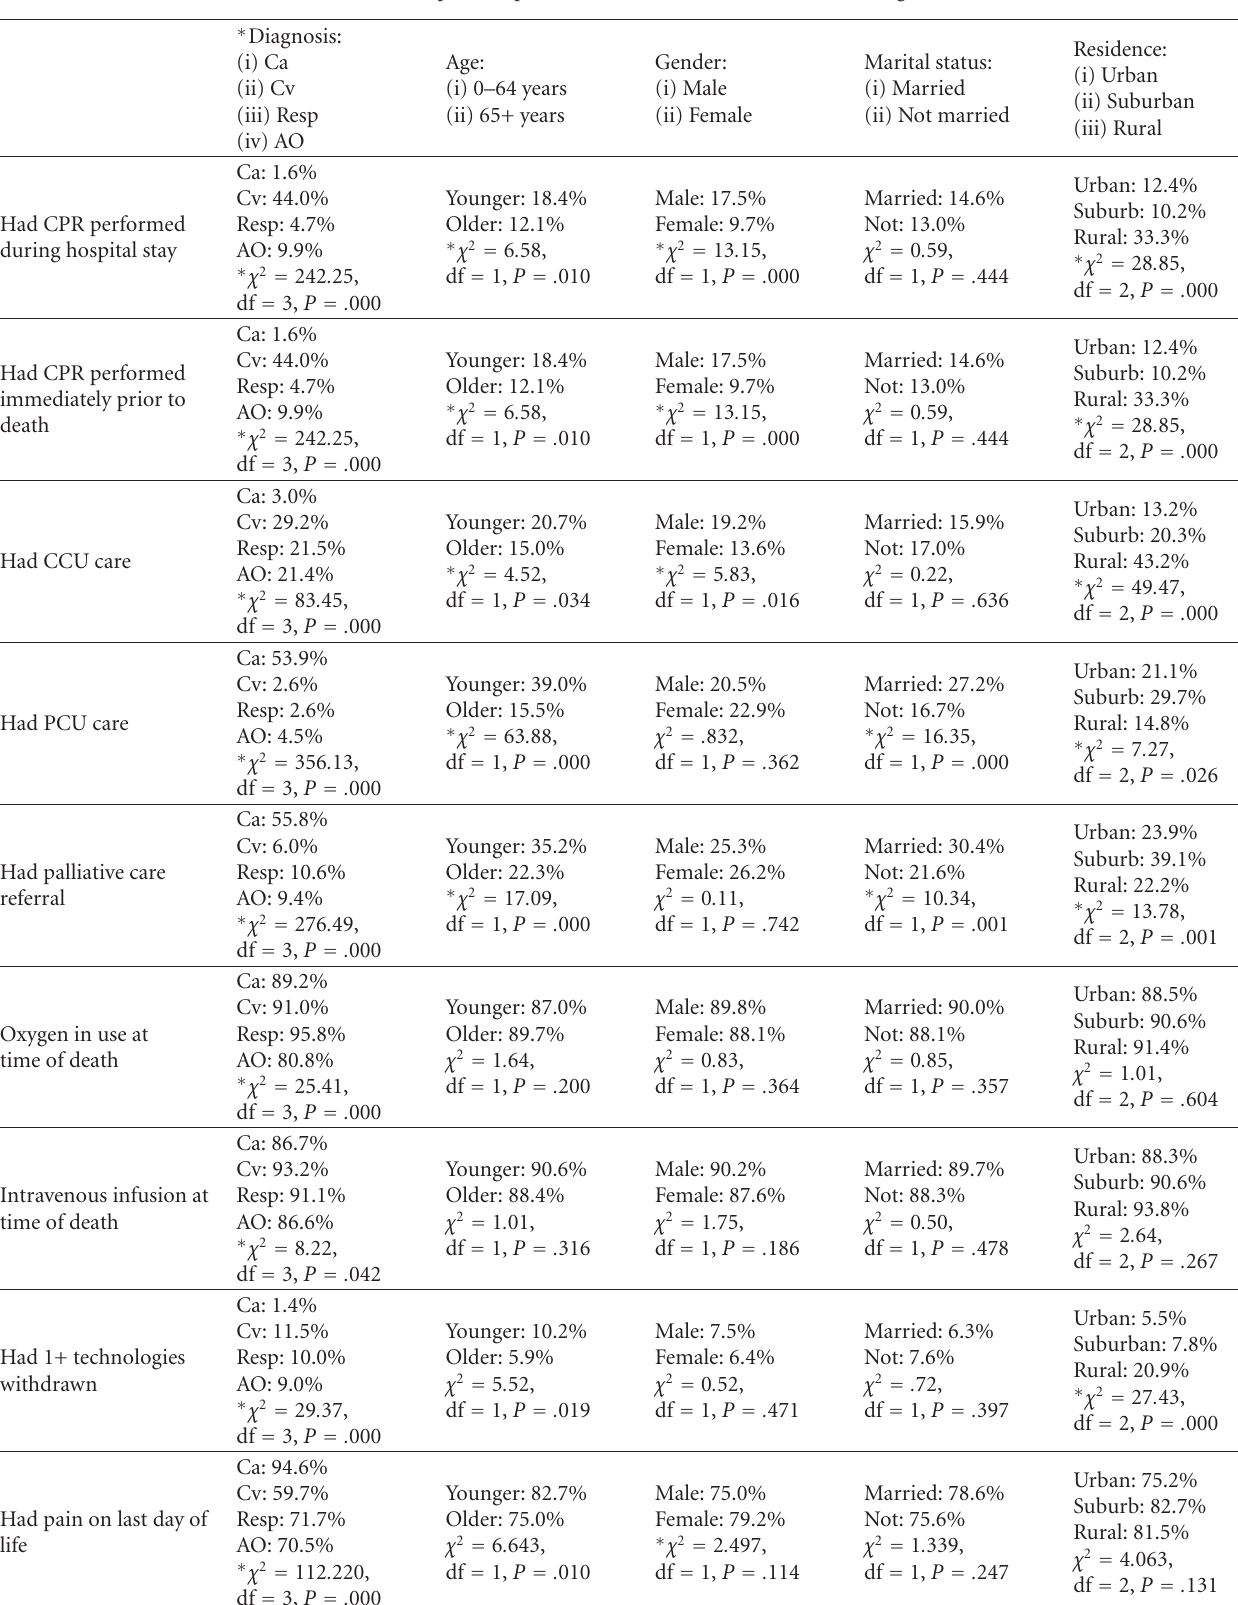
Table 1: Comparative patient characteristics and EOL care